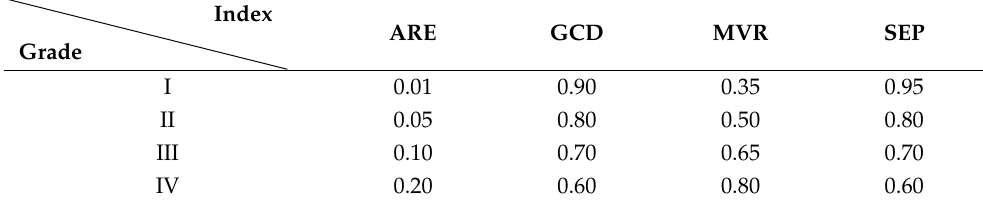
Table 1. Reference of accuracy inspection grade.